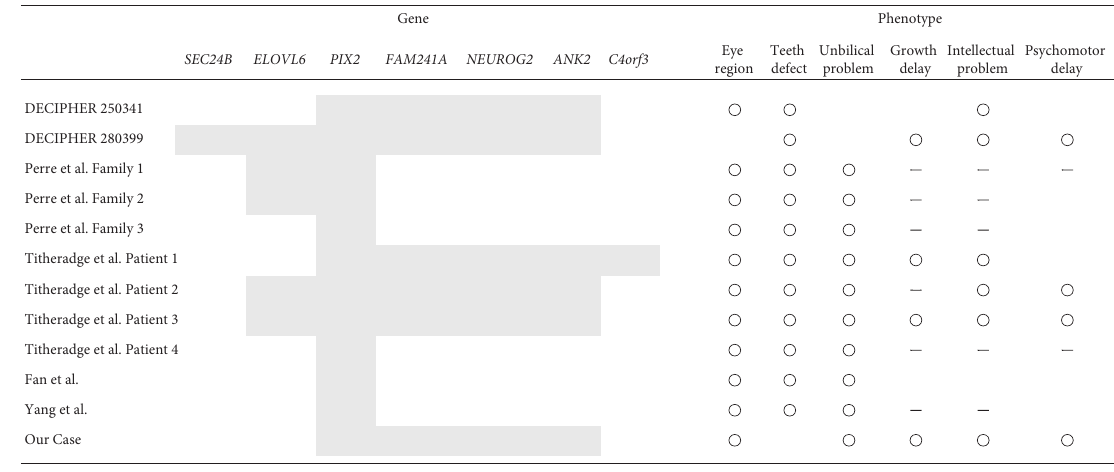
Table 1: Deletion site and clinical futures of the reported